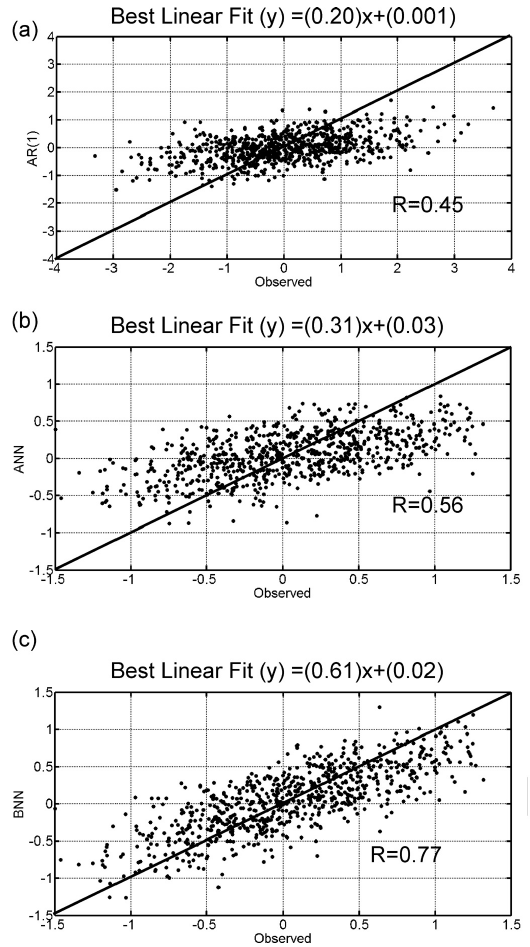
Fig. 12. The linear regression analysis of predicted value in the test period (1489AD–2000AD) by (a) autoregressive method (1), (b) artificial neural network, (c) Bayesian neural network.